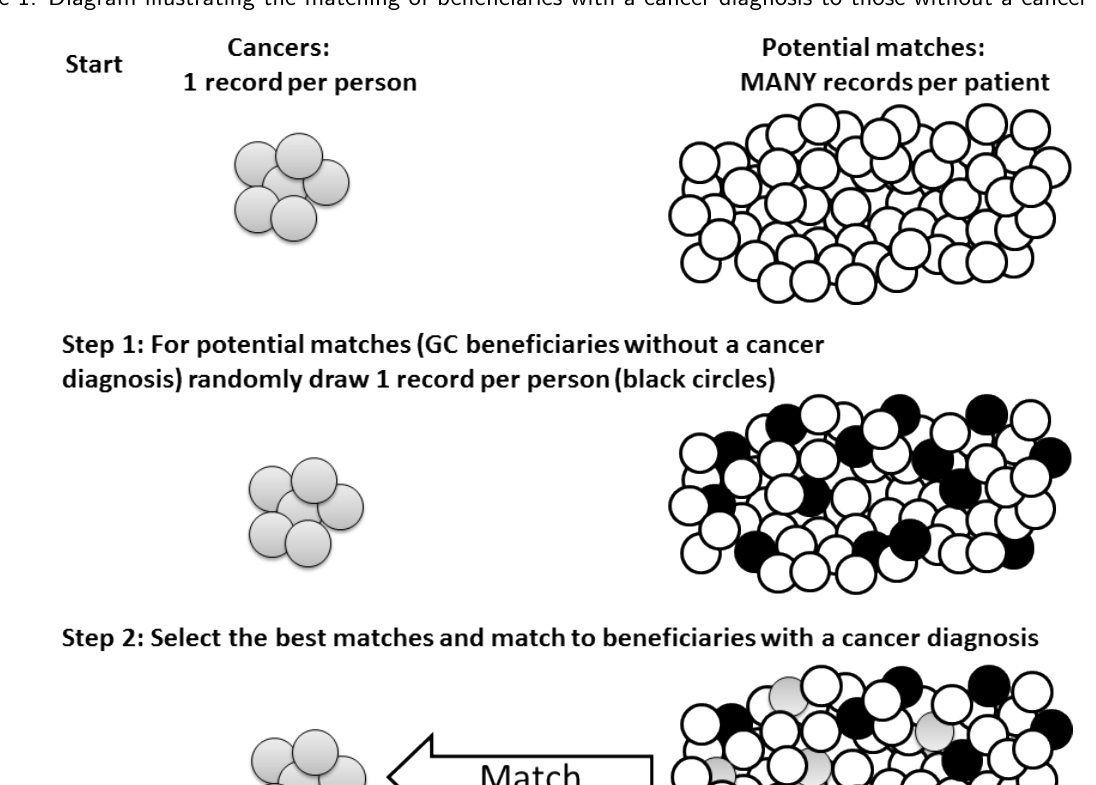
Figure 1: Diagram illustrating the matching of beneficiaries with a cancer diagnosis to those without a cancer diagnosis